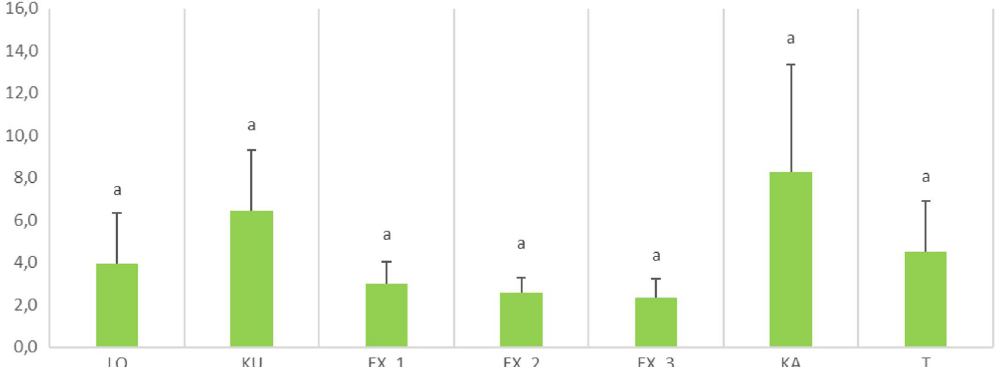
Fig. 3 Statistically significant morphometric variables (leaf number) of Plantago maxima among the Hungarian populations under study, detected by Tukey post hoc test (p < 0.05). LO 3;